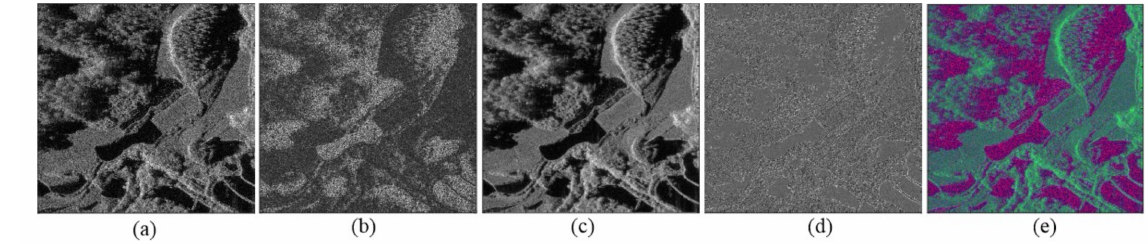
Figure 3. ( a ) SAR image. ( b ) Large gradient dominance. ( c ) Grayscale mean. ( d ) Coherence. ( e ) Fusion feature of ( b ), ( c ) and ( d ).